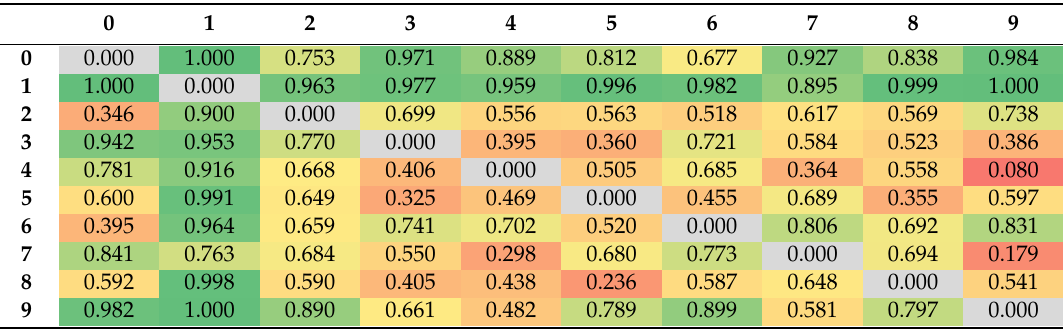
Table 1. The collection of separability indices for the input data in κ 1 , κ 2 , κ 3 projection. The e ffi ciency of data separation is color coded (vide infra) from red (no separation, ξ = 0) to green (perfect separation, ξ = 1).